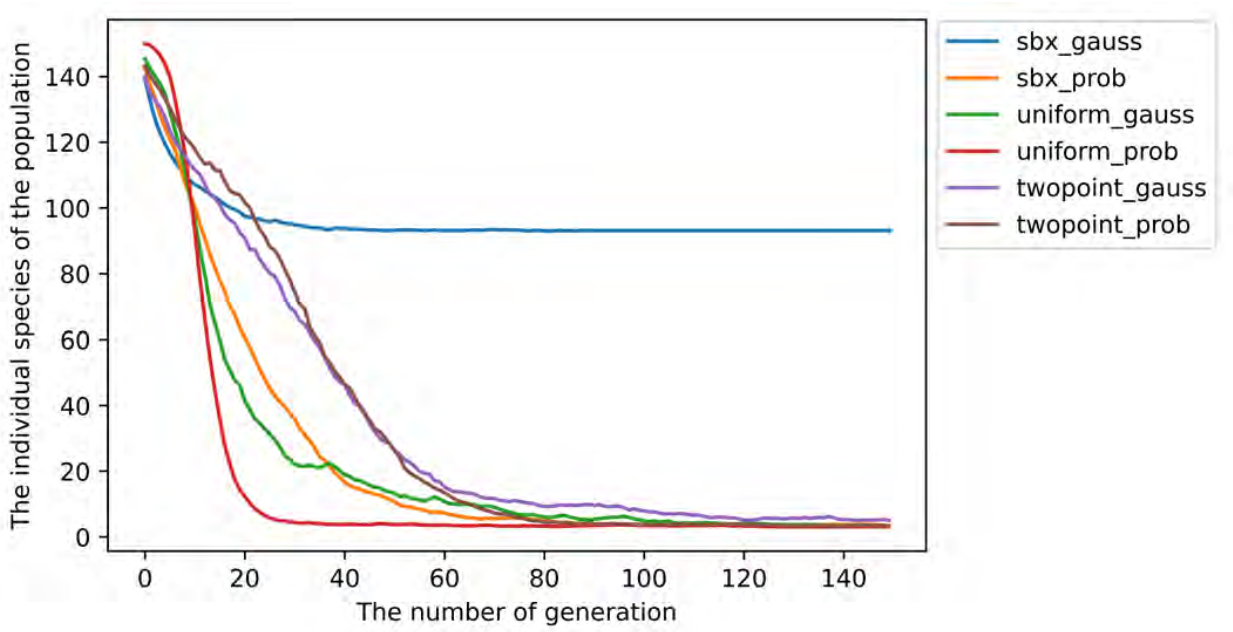
Figure 4. Effect of six gene operator combinations on the number of non-repeating individuals in the population.